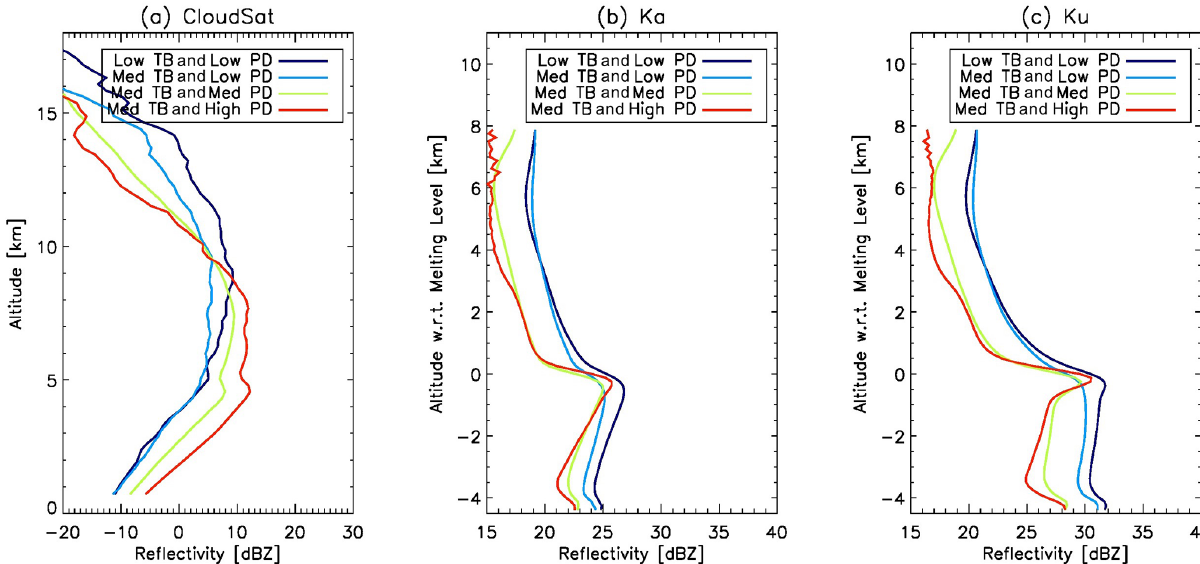
Figure 3. The collapsed 1D view of Fig. 2 after weighted averaging along the axis of absolute reflectivity (i.e., x axis) for (a) CloudSat, (b) DPR Ka and (c) DPR Ku. Note that the vertical axis for (a) is absolute altitude, whereas (b) and (c) are altitude with respect to melting level. The red (light blue) line is for the high-PD (low-PD)